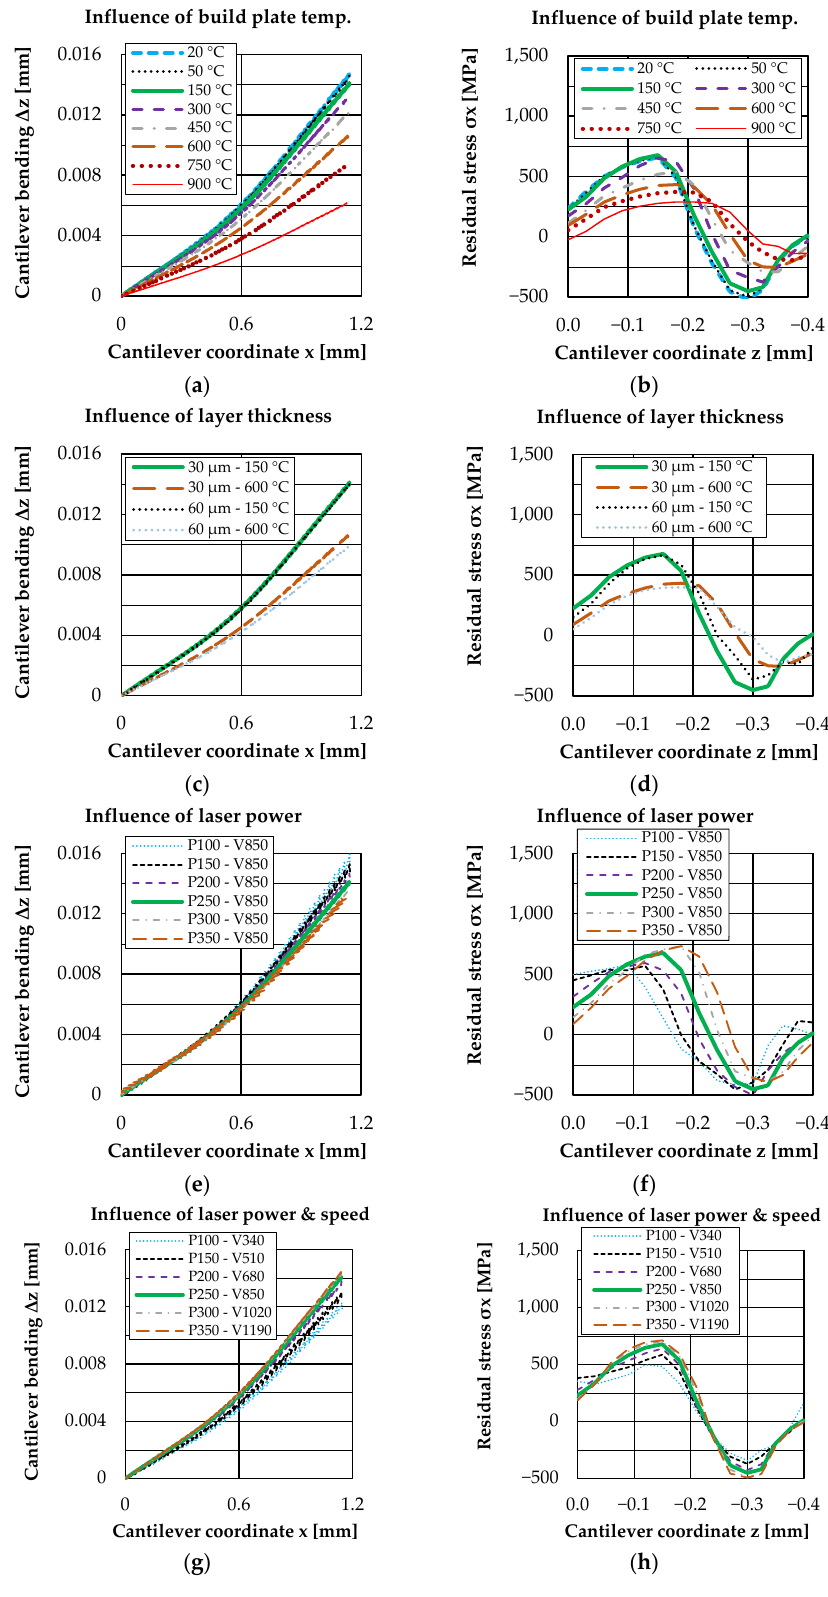
Figure 8. Results: Bending ( a ) and residual stress ( b ) for a variation of build plate temperature; bending ( c ) and residual stress ( d ) for a variation of layer thickness; bending ( e ) and residual stress ( f ) for a variation of laser power; bending ( g ) and residual stress ( h ) for a variation of laser power &